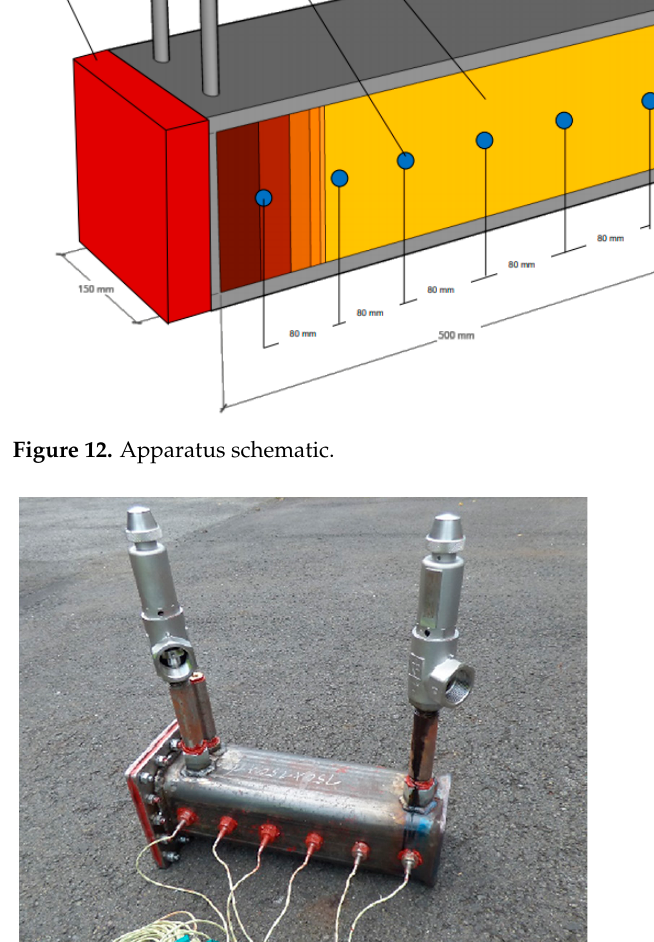
Figure 13. Apparatus as-built.